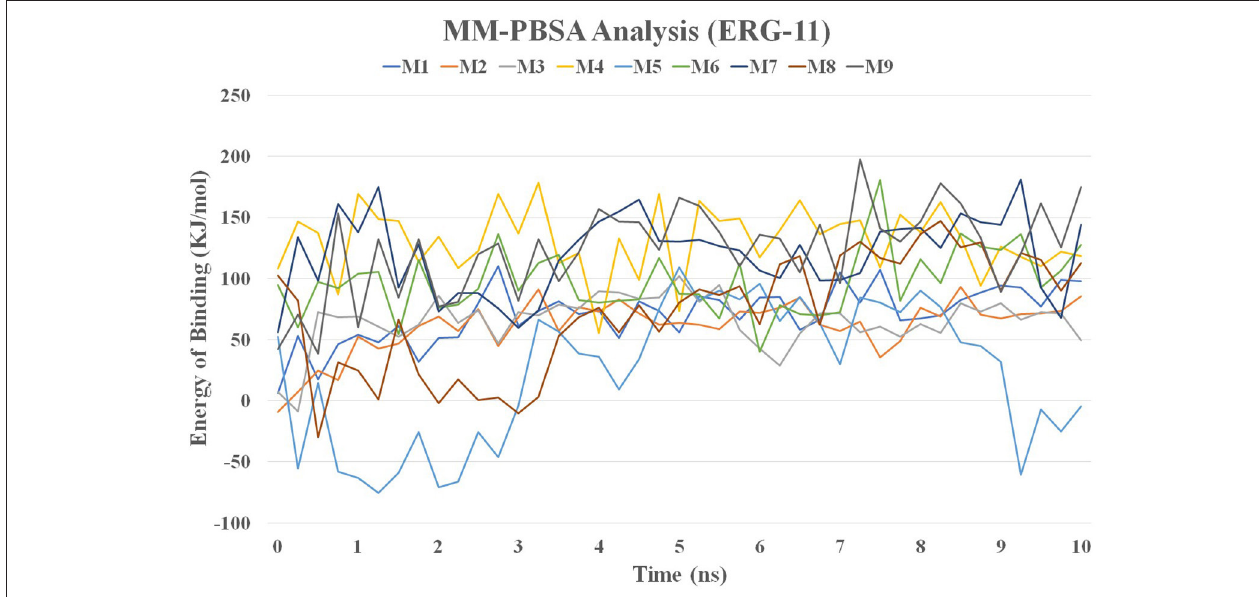
FIGURE 11 | MM-PBSA analysis of nine molecules with CYP51 during 10 ns MD simulation